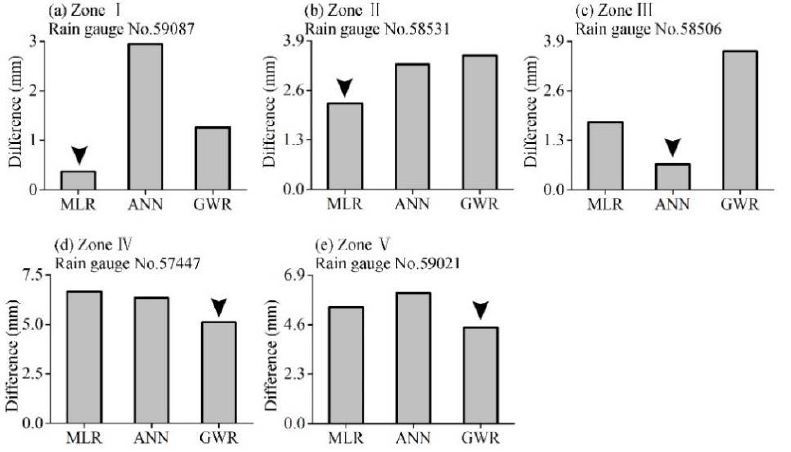
Figure 7. The precipitation difference comparison of the correction methods for sample gauges in zone Ⅰ – Ⅴ ( a – e